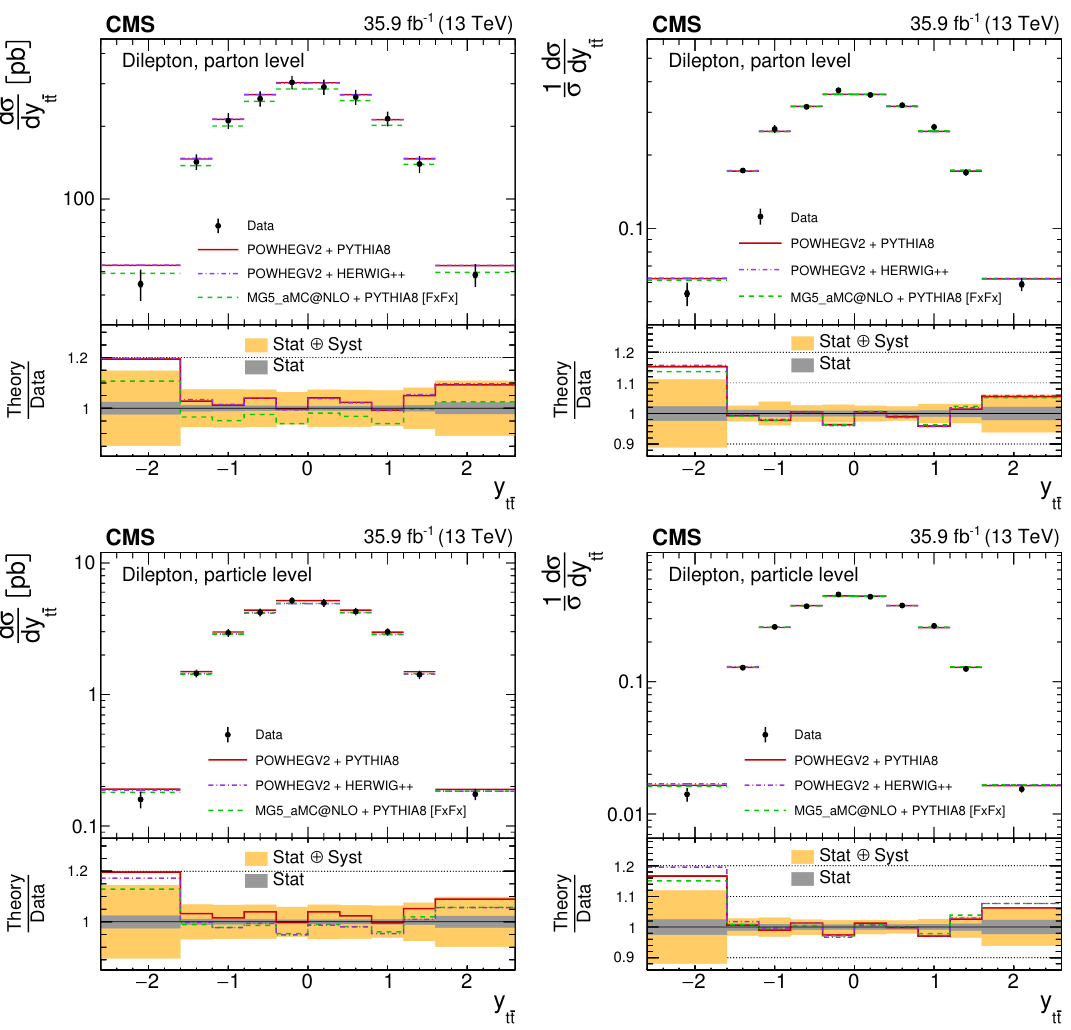
Figure 27 . The di(cid:11)erential tt production cross sections as a function of y data (points) and the MC predictions (lines). The vertical lines on the points indicate the total uncertainty in the data. The left and right columns correspond to absolute and normalised mea- surements, respectively. The upper row corresponds to measurements at the parton level in the full phase space and the lower row to the particle level in a (cid:12)ducial phase space. The lower panel in each plot shows the ratios of the theoretical predictions to the data. The dark and light bands show the relative statistical and total uncertainties in the data, respectively.